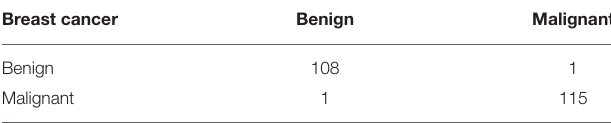
TABLE 11 | Confusion matrix of dataset C (testing).